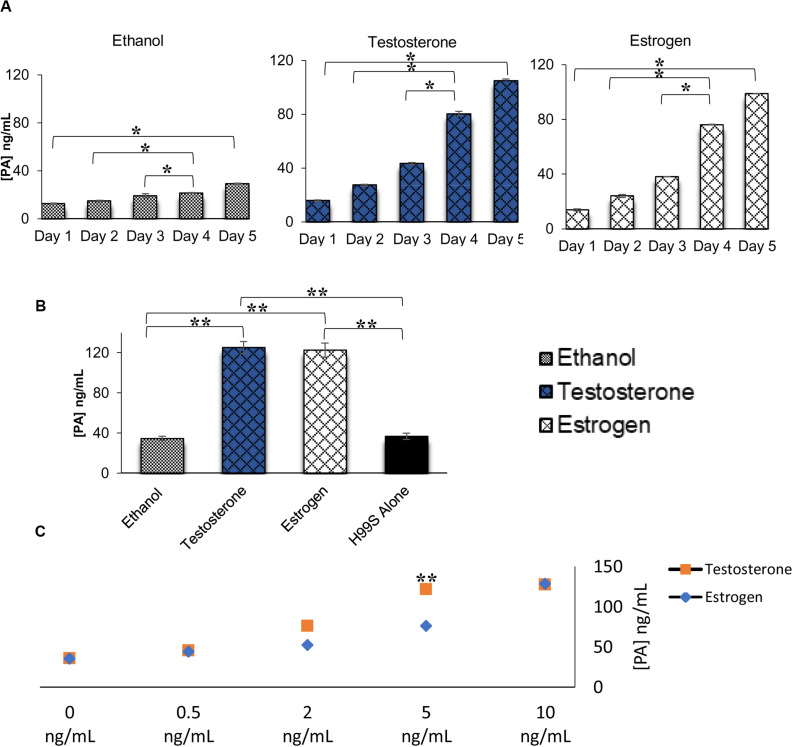
Pantothenic acid (PA) concentrations secreted from C. neoformans in various conditions using ELISA. (A) PA concentrations secreted from C. neoformans grown in steroid hormone-supplemented L-DOPA medium for 5 days. Error bars represent the standard deviation. Data is representative of three independent experiments. Statistical significance is represented as follows: *p < 0.01 comparing all days in each treatment, *p < 0.026 comparing Test to Estr over all days, using MANOVA with simple contrasts. (B) PA concentrations secreted from C. neoformans grown in steroid hormone-supplemented conditioned medium at the 32 h time point. Error bars represent the standard deviation. Data is representative of three independent experiments. Statistical significance is represented as follows: **p < 0.001, using MANOVA with simple contrasts. (C) PA concentrations secreted from C. neoformans while grown in various concentrations of testosterone and estradiol. The X-axis depicts the concentrations of testosterone and estradiol. Error bars represent the standard deviation. Data is representative of two independent experiments. **p < 0.001, using MANOVA with simple contrasts. Test, Testosterone; Estr, Estrogen (Estradiol); Eth, Ethanol.